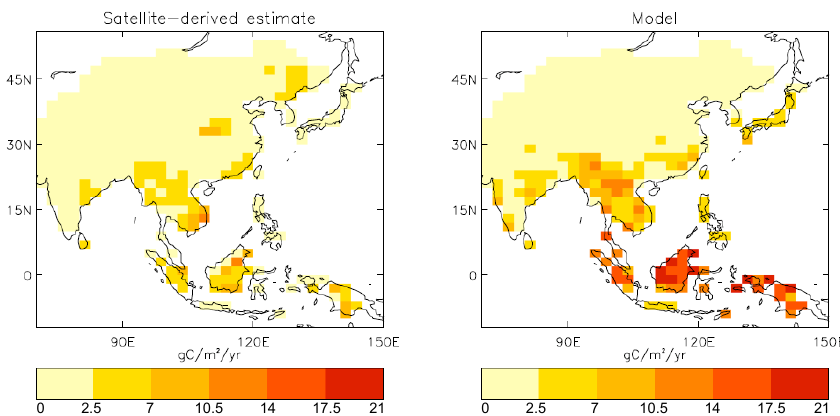
Fig. 6. Comparison of spatial patterns of simulated and satellite-derived total annual isoprene emissions over east and south Asia averaged over 1996 to 2001.